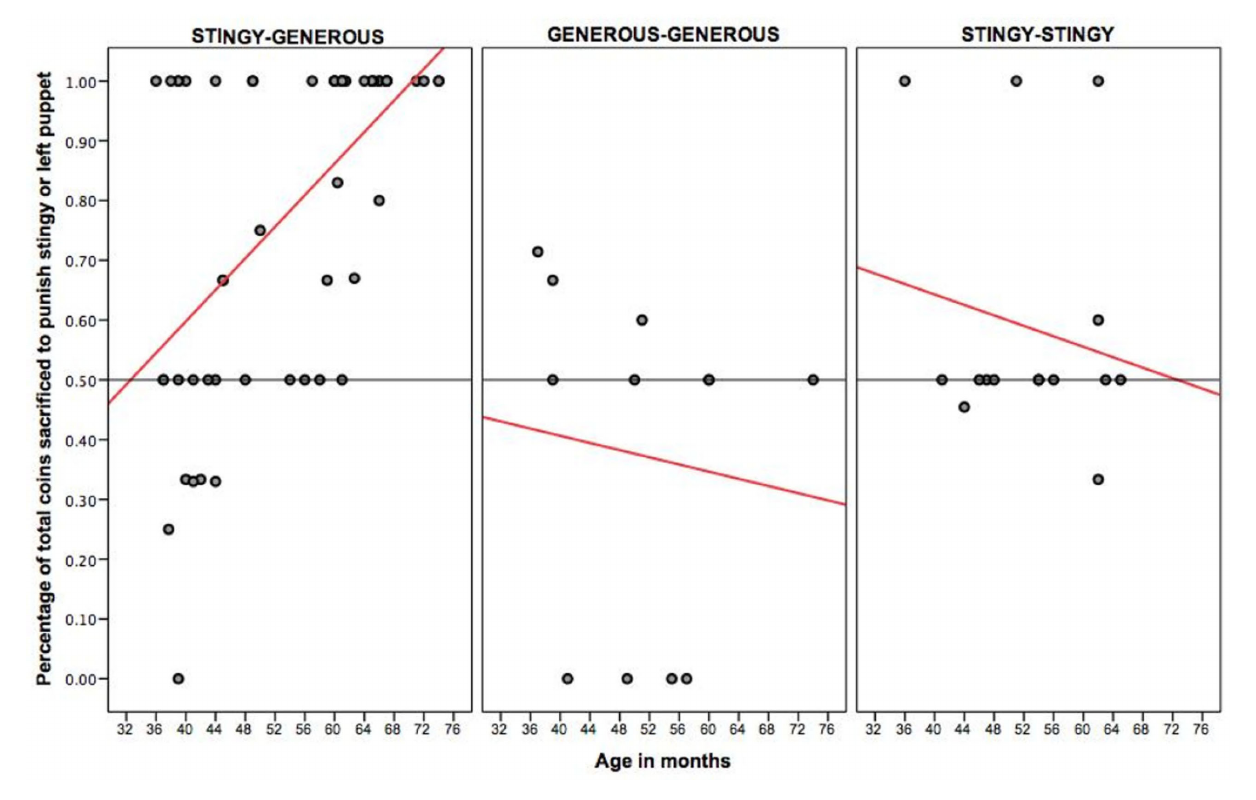
left-side puppet (Study 3, center, and Study 4, right panel) as a function of the child’s age in months.The horizontal line represents equal punishment toward the two